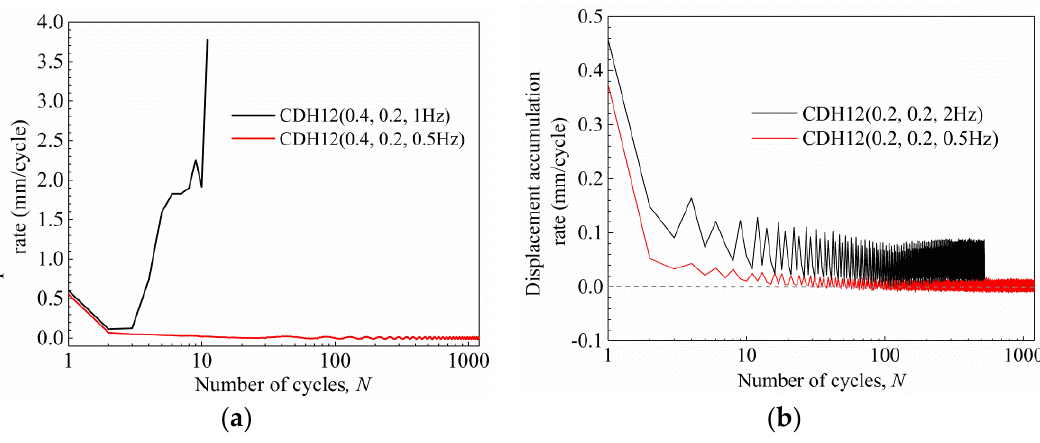
Figure 15. Developments of accumulated displacement under different frequencies.